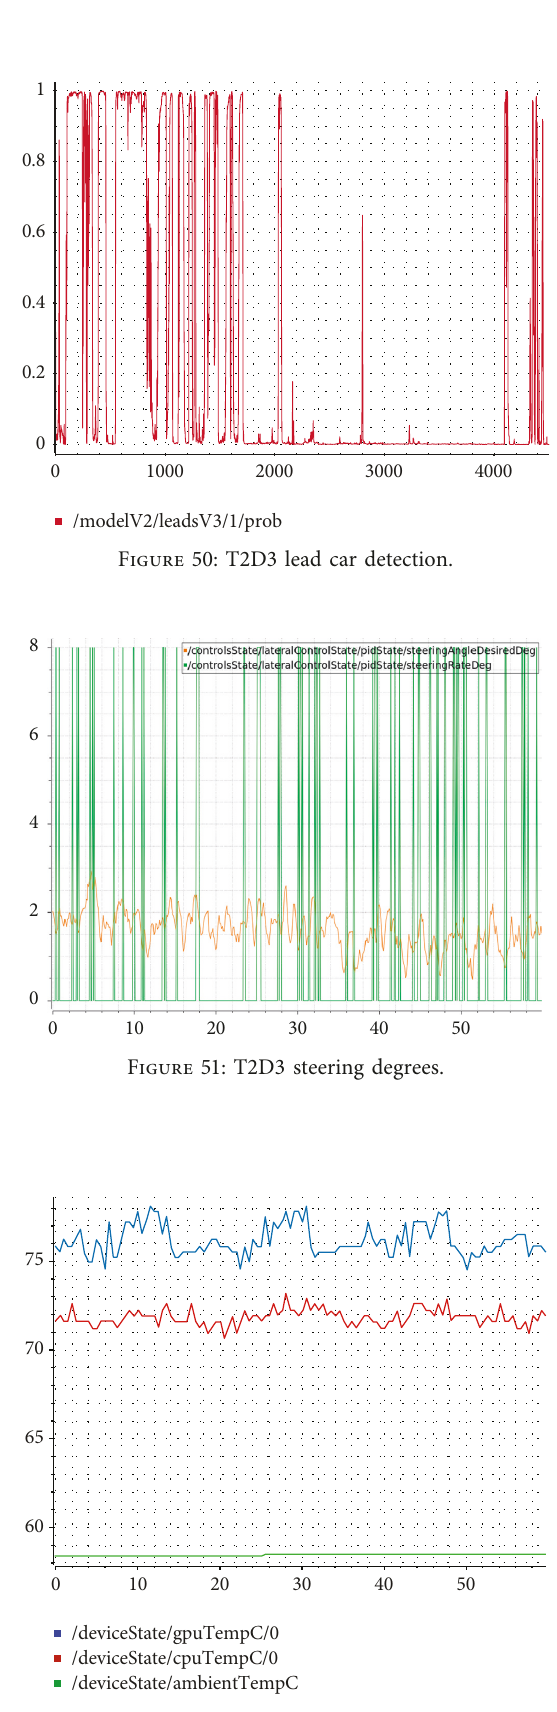
Figure 52: T2D2 lead car